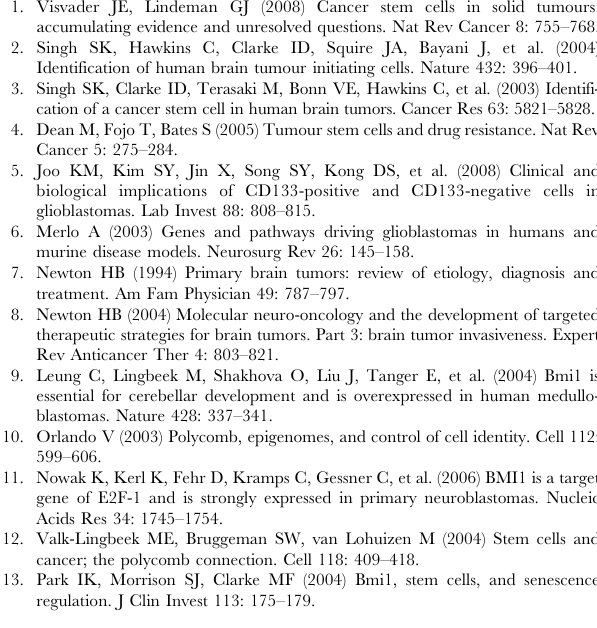
Figure S4 Cell cycle analysis in GBM cell lines treated with LiCl. The GBM cell lines LN319, LN18, U373 and LN215 were treated with 10 or 20 mM LiCl for 24 hours. Percentage of the cells in G1, S and G2-M phase of the cell cycle were evaluated